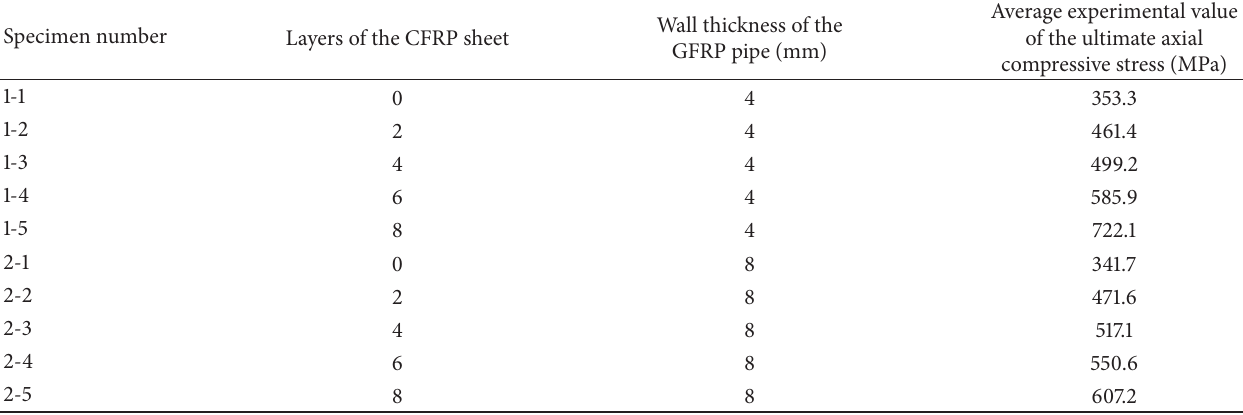
Table 2: Ultimate axial compressive stress of the specimens attained by